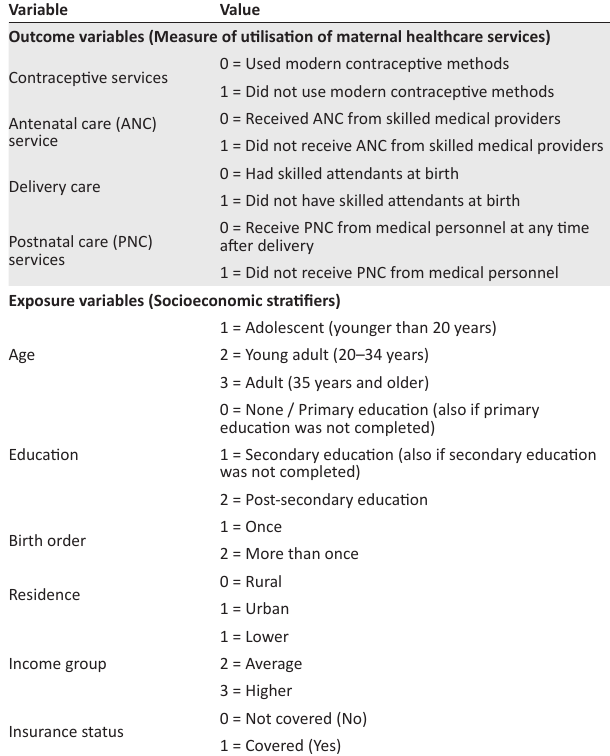
TABLE 2: Classification of variables in bivariate and multi variate analysis and their respective values.